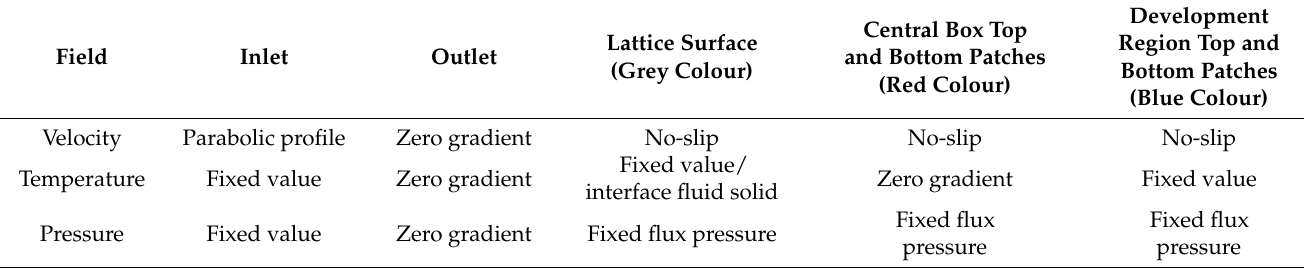
Table 4. Summary of the selected boundary conditions. The colour of the patches refers to Figure 3. Note that the fixed values are not the same for all simulations, thus they are not made explicit in this